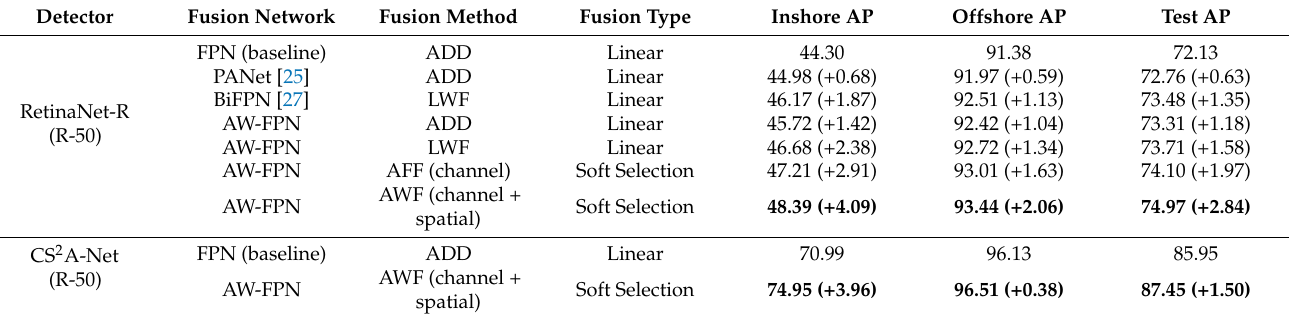
Table 7. Comparison of different feature fusion networks on RSSD. The structure of all feature fusion networks is used only once in our experiment. Here, ADD represents the direct addition of feature maps, while LWF indicates the linear weighted fusion method in BiFPN [27].